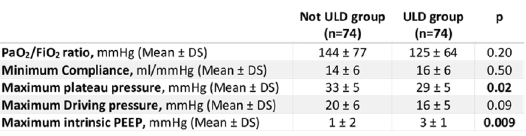
Table 1: comparison of ventilator parameters and lung mechanics between both